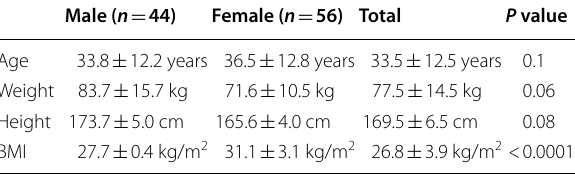
Table 1 Demographic data and patient